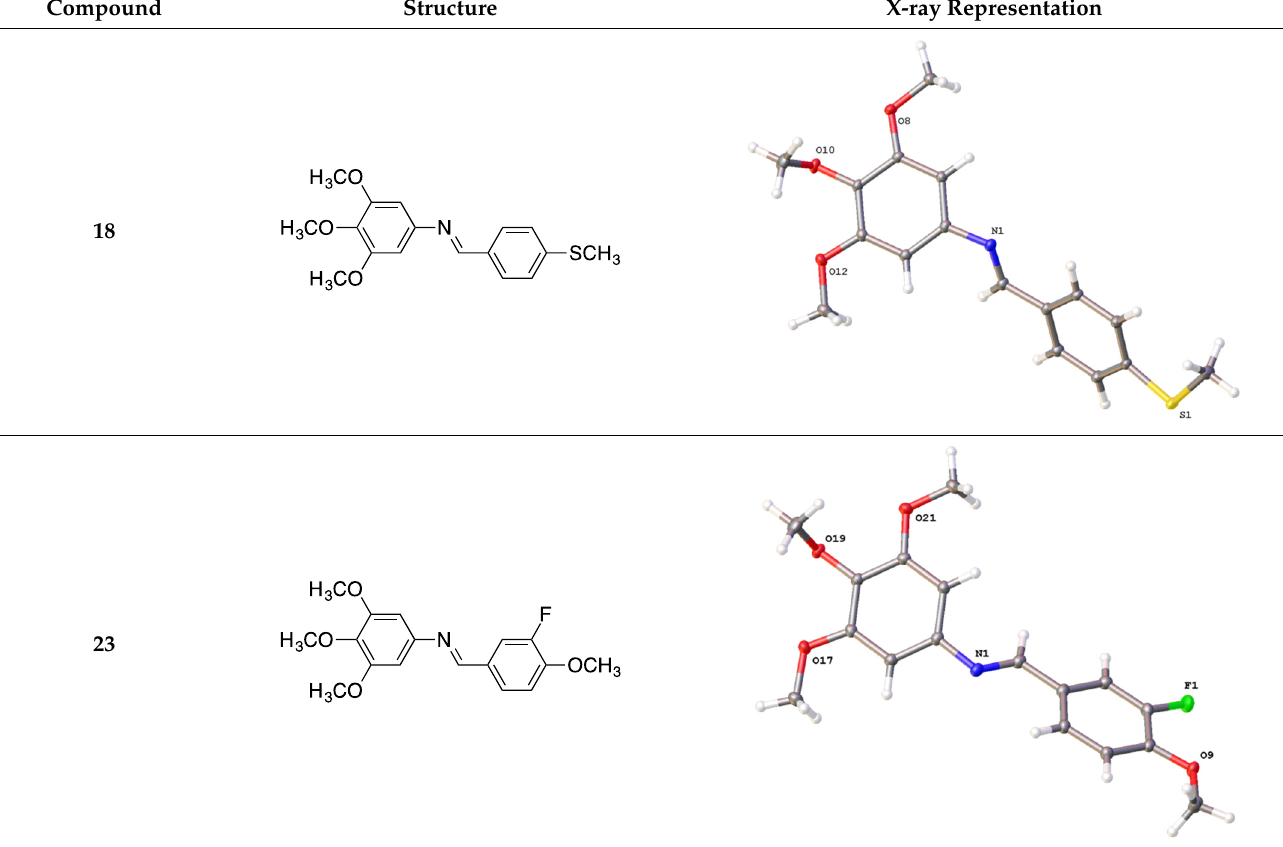
Table 1. X-ray crystal structures of imines 18 and 23 .